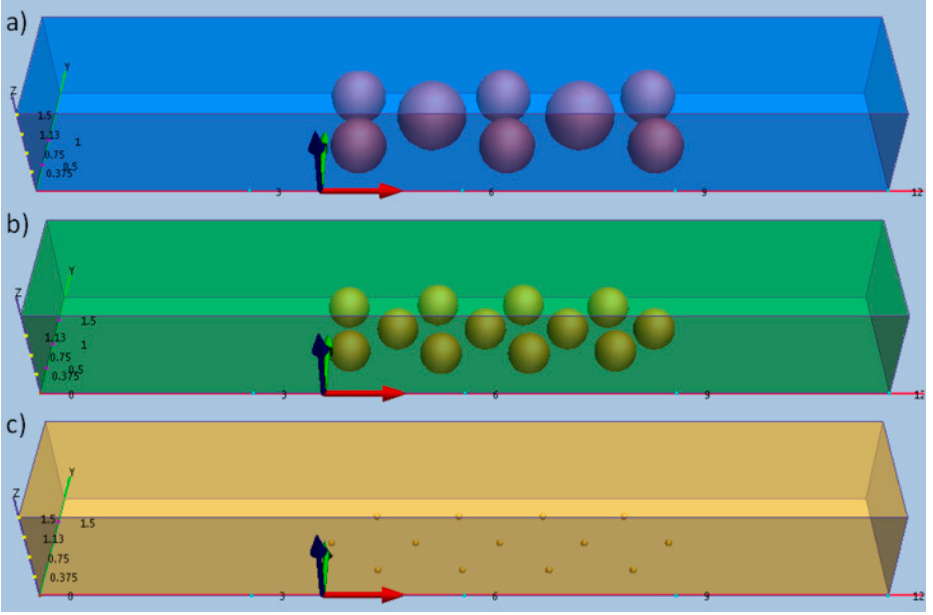
Figure 1. Three-dimensional schemes of the physical model with different sizes of microspheric structures under laser parameters: ( a ) 30% power and 60% speed (P3-S6), ( b ) 40% power and 50% speed (P4-S5), and ( c ) 40% power and 40% speed (P4-S4).